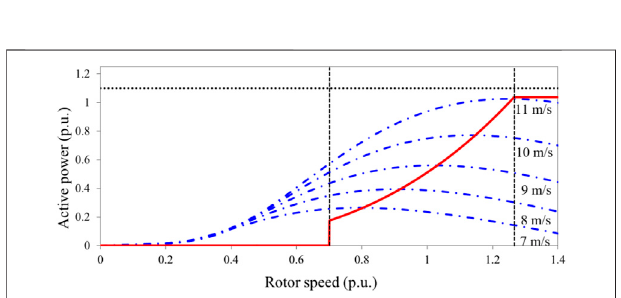
FIGURE 7 | Tandem-compound, single-reheat governor model.